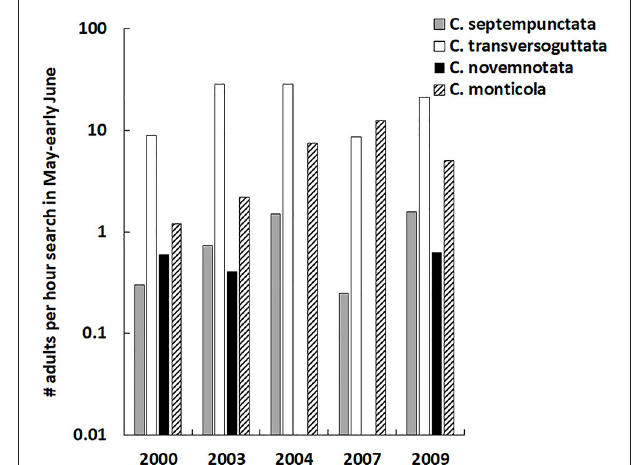
FIGURE 3 | The number of adults of Coccinella spp. ( C. septempunctata , C. tranversoguttata , C. novemnotata , and C. monticola ) per hour of visual search of the vegetation in montane sagebrush steppe in northern Utah during May and early June, 2000–2009 (note log scale for y-axis).